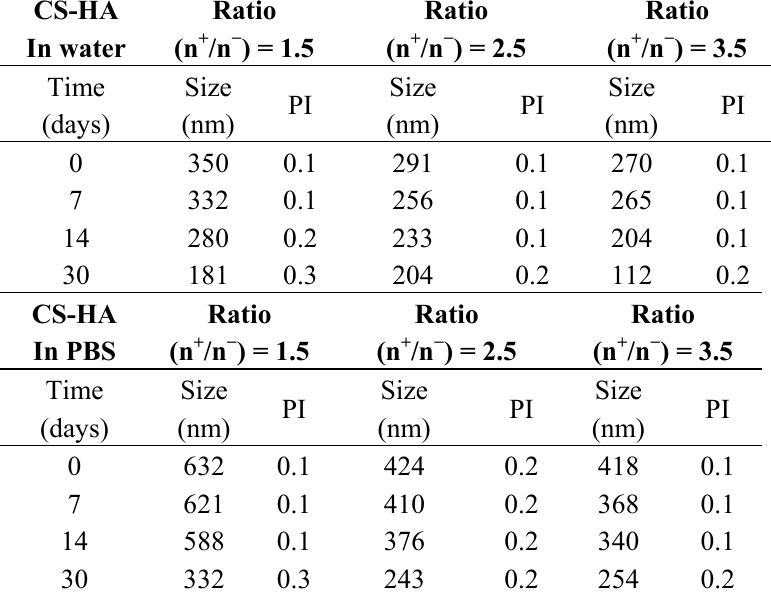
Table 3. CS-HA nanoparticle colloidal stability with time as a function of buffers and charge ratio (chitosan: DA 48%, molar mass 130 × 10 3 g/mol; hyaluronic acid 50 × 10 3